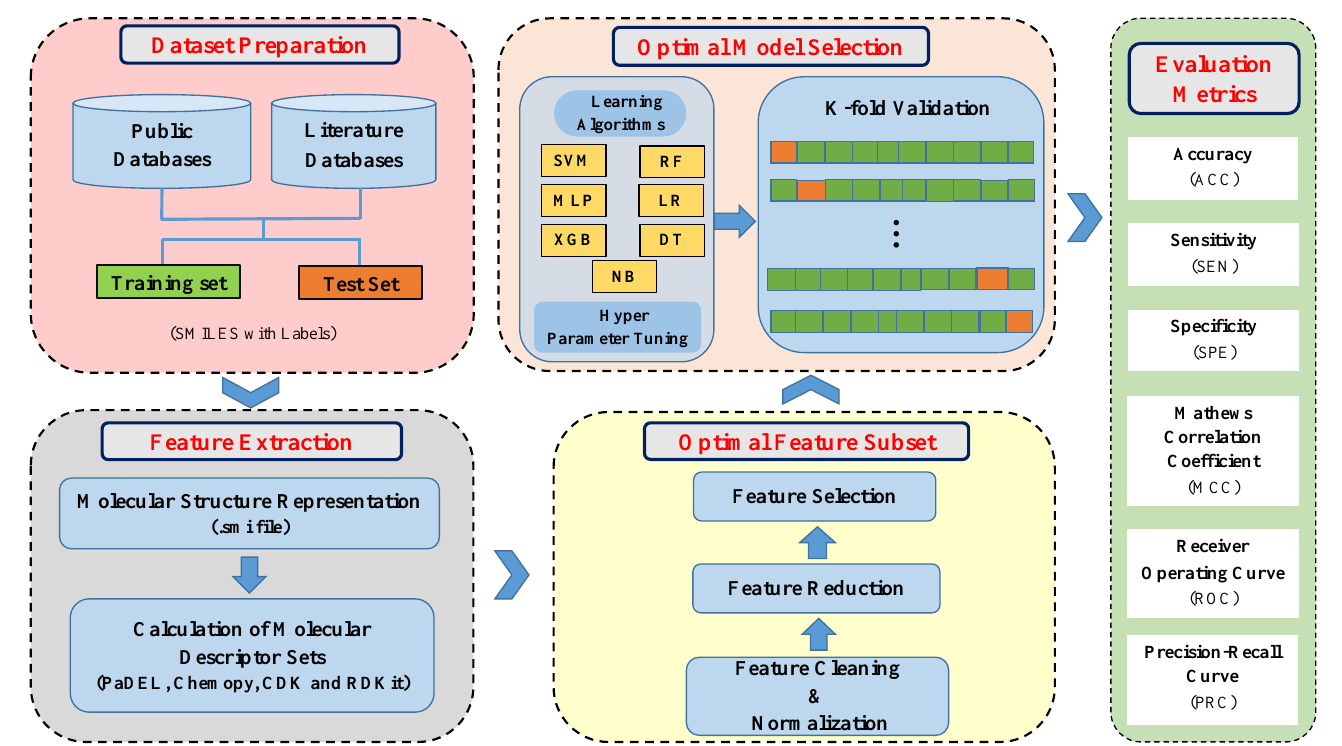
Figure 1. Illustration of the overall